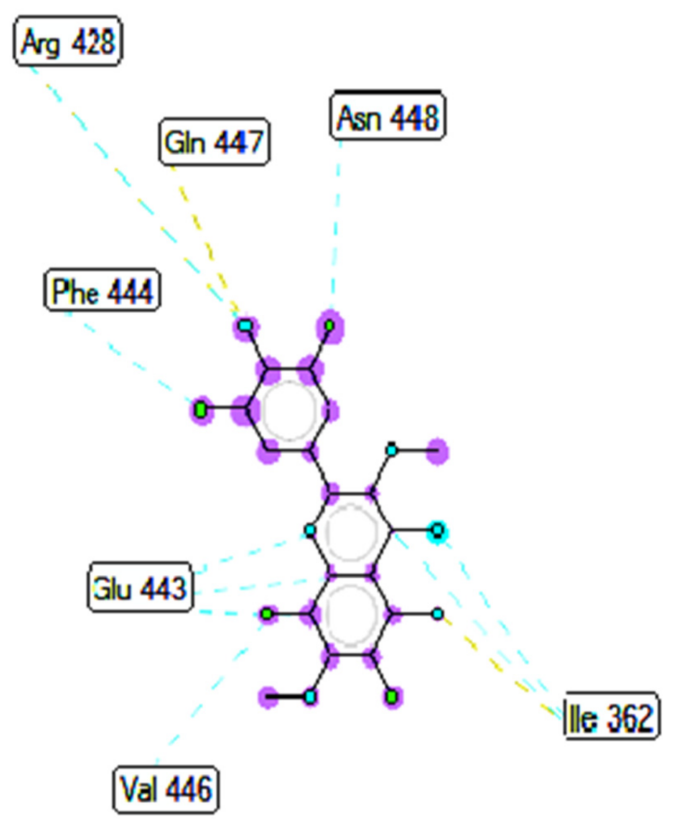
Figure 6. The ligand map was formed by the conformation ligand of 11 and receptor 4J5T , a crystal structure of enzyme, alpha-glucosidase.